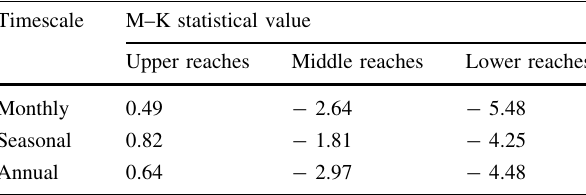
Table 2 Temporal trends of drought at different timescales in the Heihe River Basin subareas during